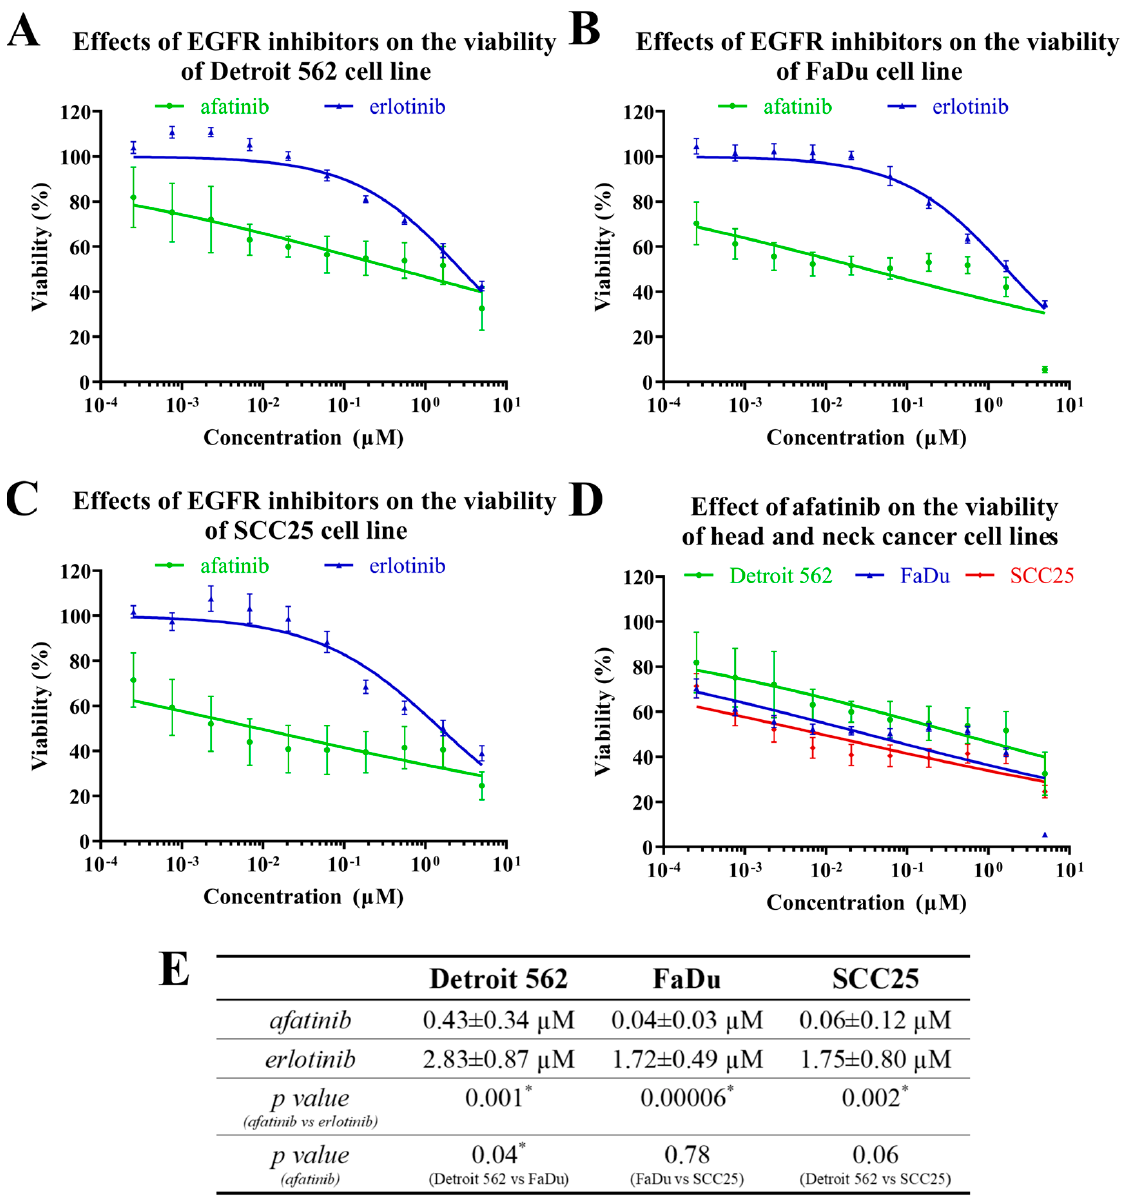
Figure 3. The effects of EGFR inhibitors on head-and-neck-cancer-cell viability. Cell lines were treated with afatinib or erlotinib at different concentrations for 72 h and cell viability was determined by MTT assay. The IC 50 curves of the effects of the inhibitors on Detroit 562 ( A ), FaDu ( B ) and SCC25 ( C ) cell lines are shown. The IC 50 curves of the effects of the afatinib on the three HNSCC cell lines are shown in a common diagram ( D ) for better comparison. ( E ) The IC 50 values for the effects of the EGFR inhibitors on Detroit 562, FaDu and SCC25 cells. All data are represented as the mean ± SD of five independent measurements. The IC 50 values ( E ) of the two inhibitors were compared to each other and Student’s t -tests were performed for statistically significant differences; * p < 0.05 afatinib vs. erlotinib and one afatinib-treated cell line vs. another.